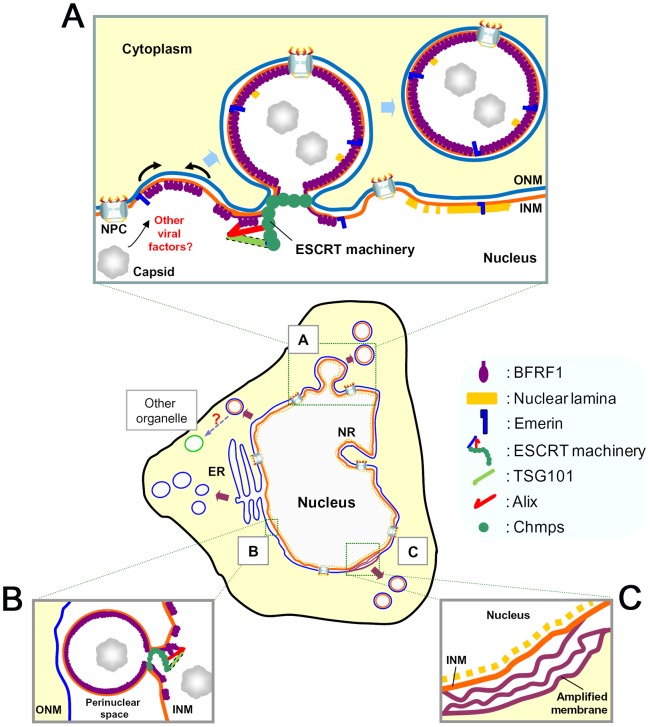
A hypothetical model of the interaction among EBV BFRF1 and cellular ESCRT components in vesicle formation and modulation of the nuclear membrane.After EBV reactivation, membrane anchoring BFRF1 targets to the nucleus associated membranes. BFRF1 potentially regulates the membrane through protein oligomerization and then recruits Alix and, sequentially, other ESCRT components to derive the vesicles from the double layer nuclear envelope (A), outer nuclear membrane (ONM) or from inner nuclear membrane (INM) (B). These nuclear membrane-derived vesicles may contain some nucleoporins and other INM proteins, such as lamin A/C or emerin. Cooperating with other viral factors, such as BFLF2, the BFRF1-mediated vesicles may further recruit and pack some nucleocapsids for the subsequent nuclear egress. Additionally, the expression of BFRF1 induces the formation of multilayered cisternal nuclear membranes (C), which may provide more membranous structure for viral budding. ER, endoplasmic reticulum. NPC, nuclear pore complex.